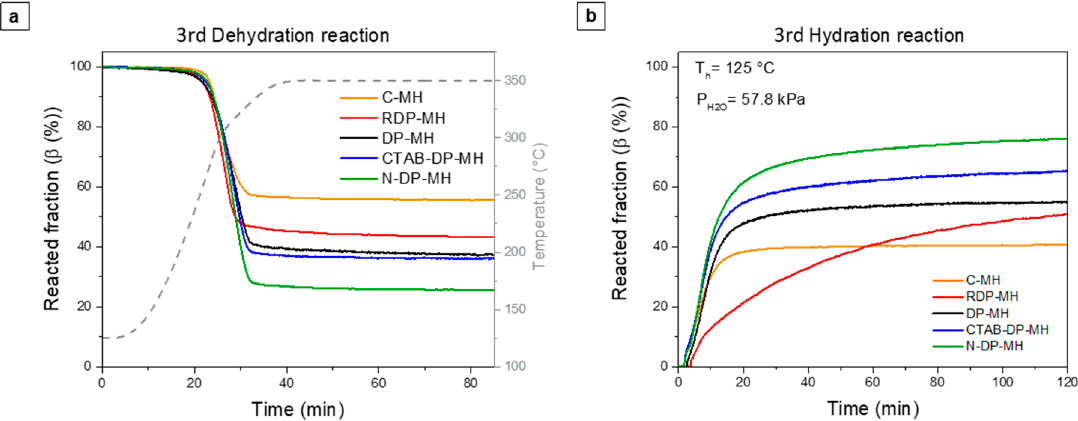
Figure 7. ( a ) Dehydration and ( b ) hydration curves at the 3rd cycle.